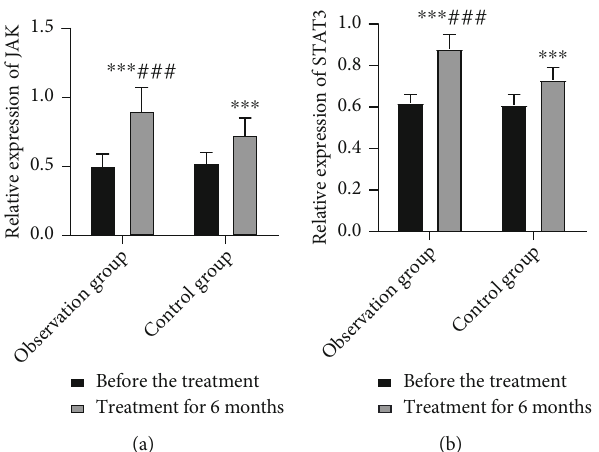
Figure 3: Comparison of JAK/STAT3 relative expression levels in both groups. (a) JAK expression level; (b) STAT3 expression level. Compared with pretreatment, ∗∗∗ P < 0 : 001 ; compared with the control group, ### P < 0 : 001